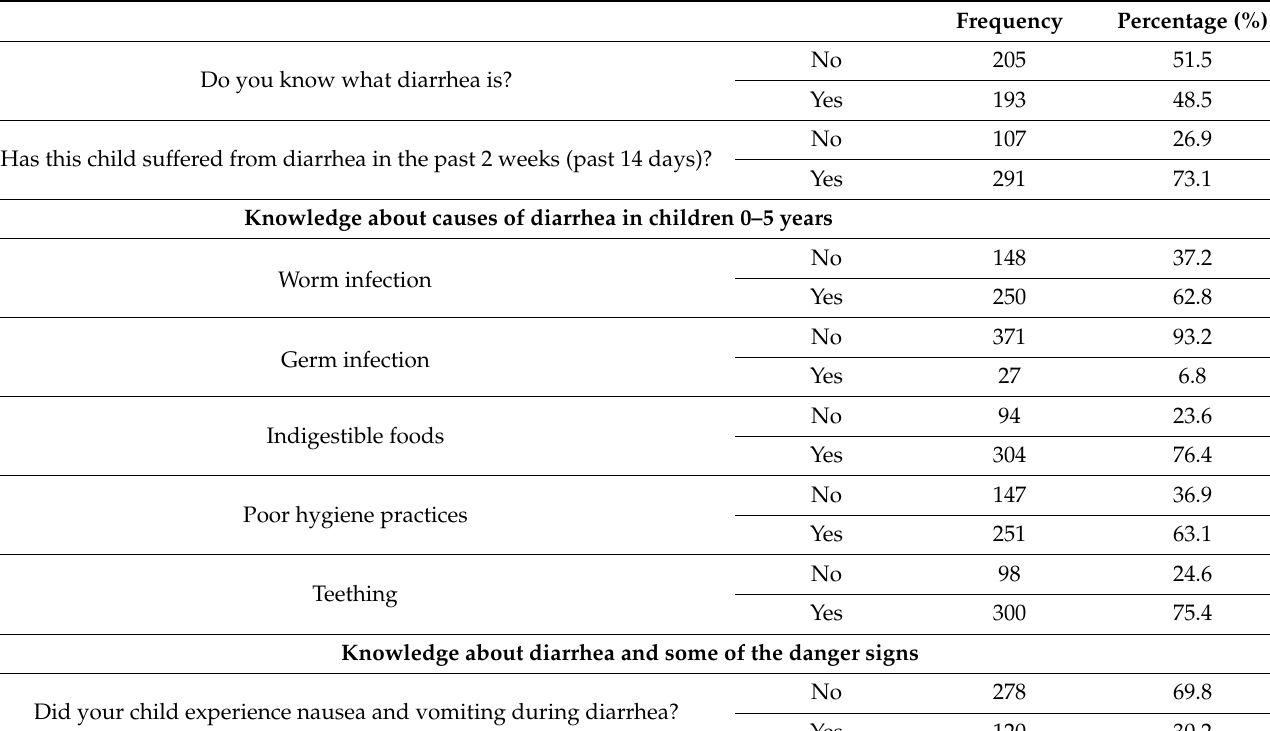
Table 2. Caregiver knowledge regarding causes and danger signs of diarrhea in children <5